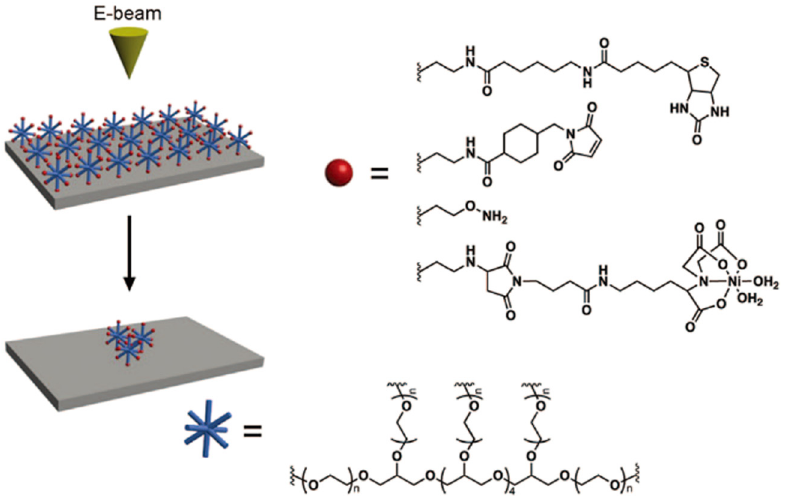
Figure 8: End - functionalized eight - arm PEG polymers were cross - linked in speci fi c patterns using electron beam lithography for protein patterning ( reproduced from ref. [ 81 ]) .